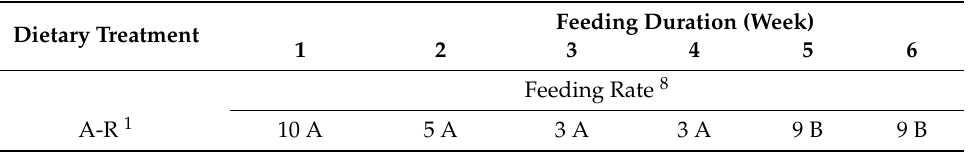
Table 3. Feeding rate (based on a percentage of body weight) for lake sturgeon during 6 weeks of feeding (Feeding trial II). Dietary